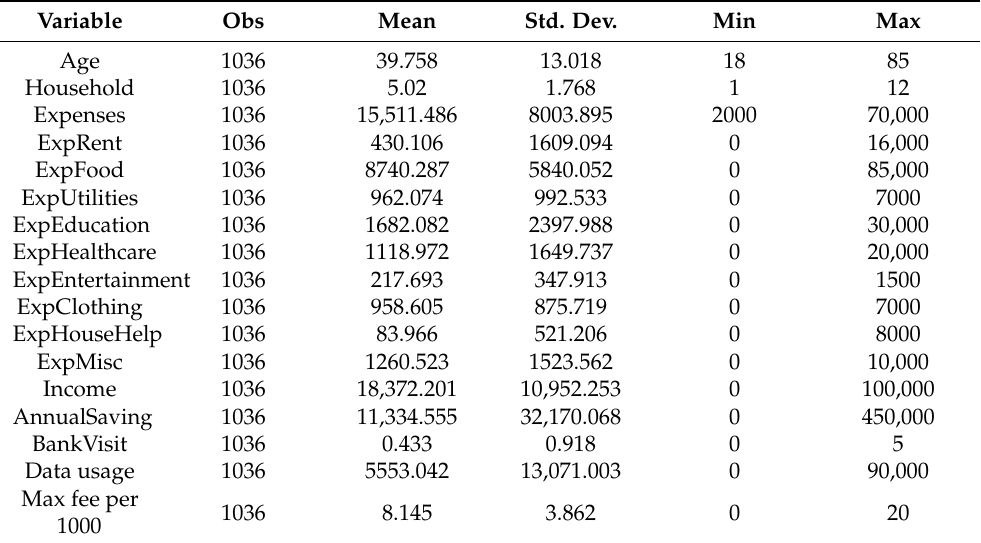
Table 2. Descriptive Statistics of Numeric